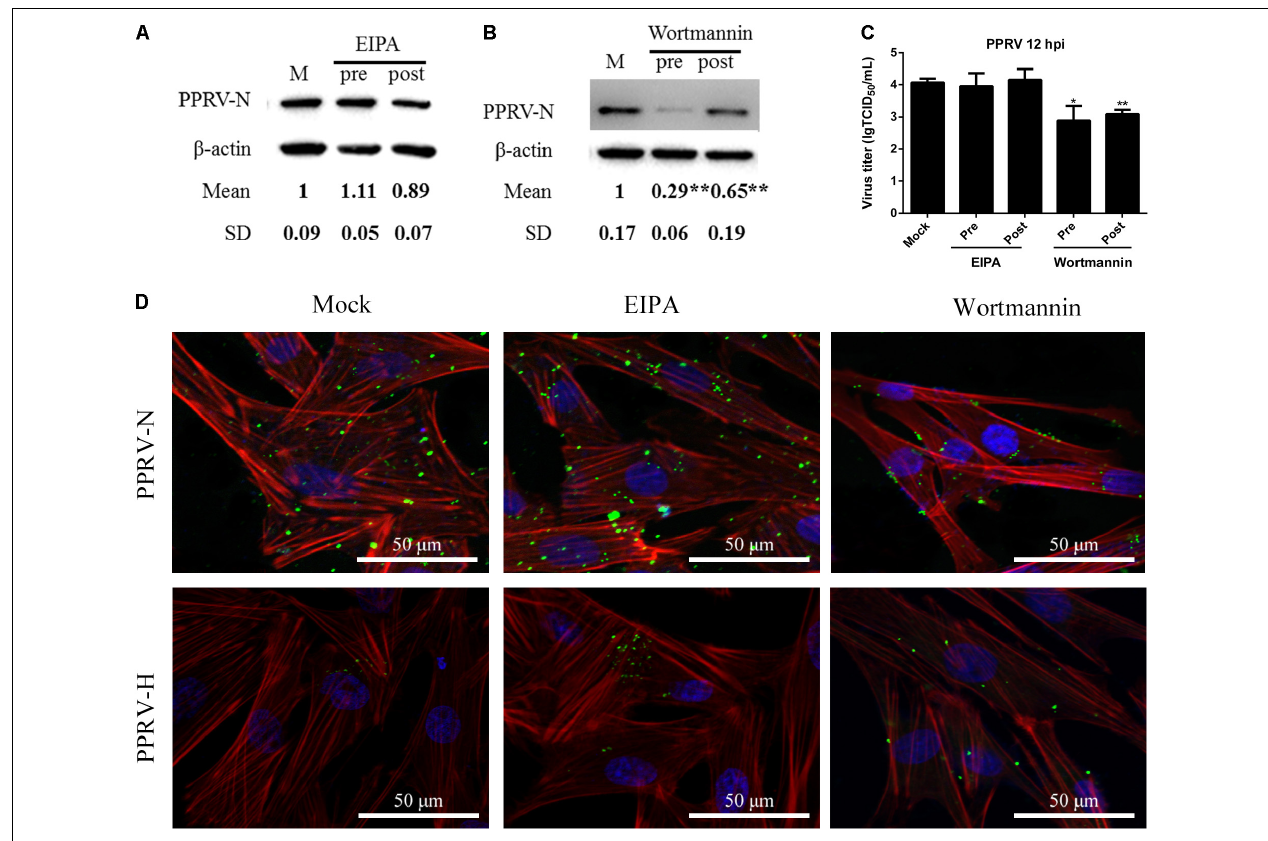
FIGURE 7 | Peste des petits ruminants virus entry does not depend on macropinocytosis but requires PI3K. (A,B) Western blot analysis of viral protein expression in mock-, EIPA- or wortmannin-treated cells. Cells were treated with EIPA and wortmannin 1 h before (Pre) or 1 h after virus addition (Post) and this was maintained during infection. After 12 hpi (PPRV, MOI 10), equivalent amounts of protein were analyzed by western blot using an anti-PPRV-N antibody. β -actin was used as an internal control. (C) Virus titration analysis of PPRV treated with EIPA and wortmannin. (D) CLSM analysis of TRITC-phalloidin (red), anti-PPRV (green) and DAPI (blue) in PPRV-infected EECs pre-treated with EIPA and wortmannin. The bars indicate the mean ± SD from three independent experiments. SD, standard deviation; ∗ P < 0.05; ∗∗ P <